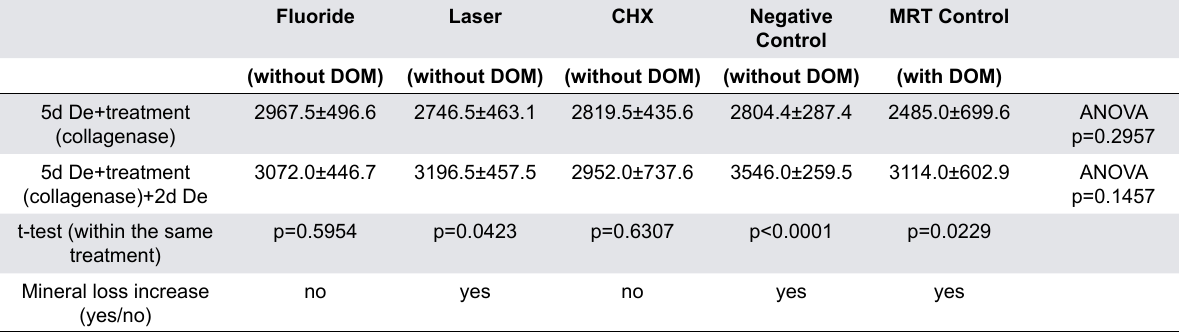
Figure 2- Amount of HYP (µg/mL) released from the dentin samples in each group Table 1- Integrated mineral loss (ΔZ, %vol.μm) of dentin after different experimental